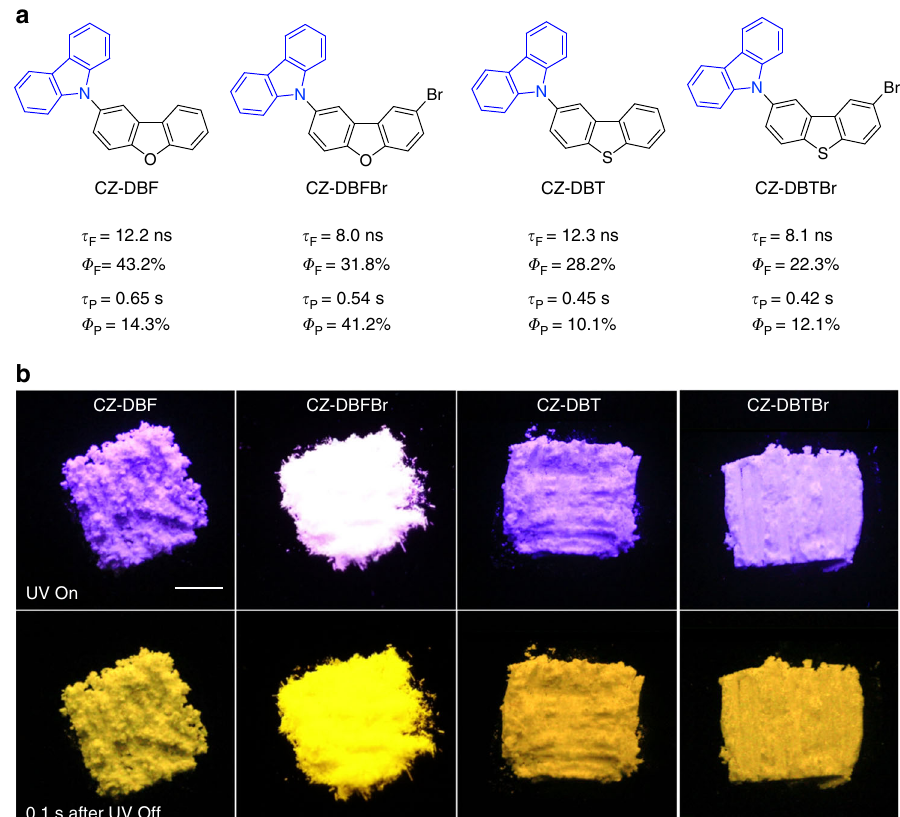
Fig. 2 Chemical structure and luminescent performance of OPRTP compounds. a Molecular structures of OPRTP materials with dual fl uorescence and phosphorescence lifetimes and quantum yields. b Photographs of crystalline powders taken before and after removal of UV excitation source of 365 nm at ambient conditions. Scale bar = 0.5